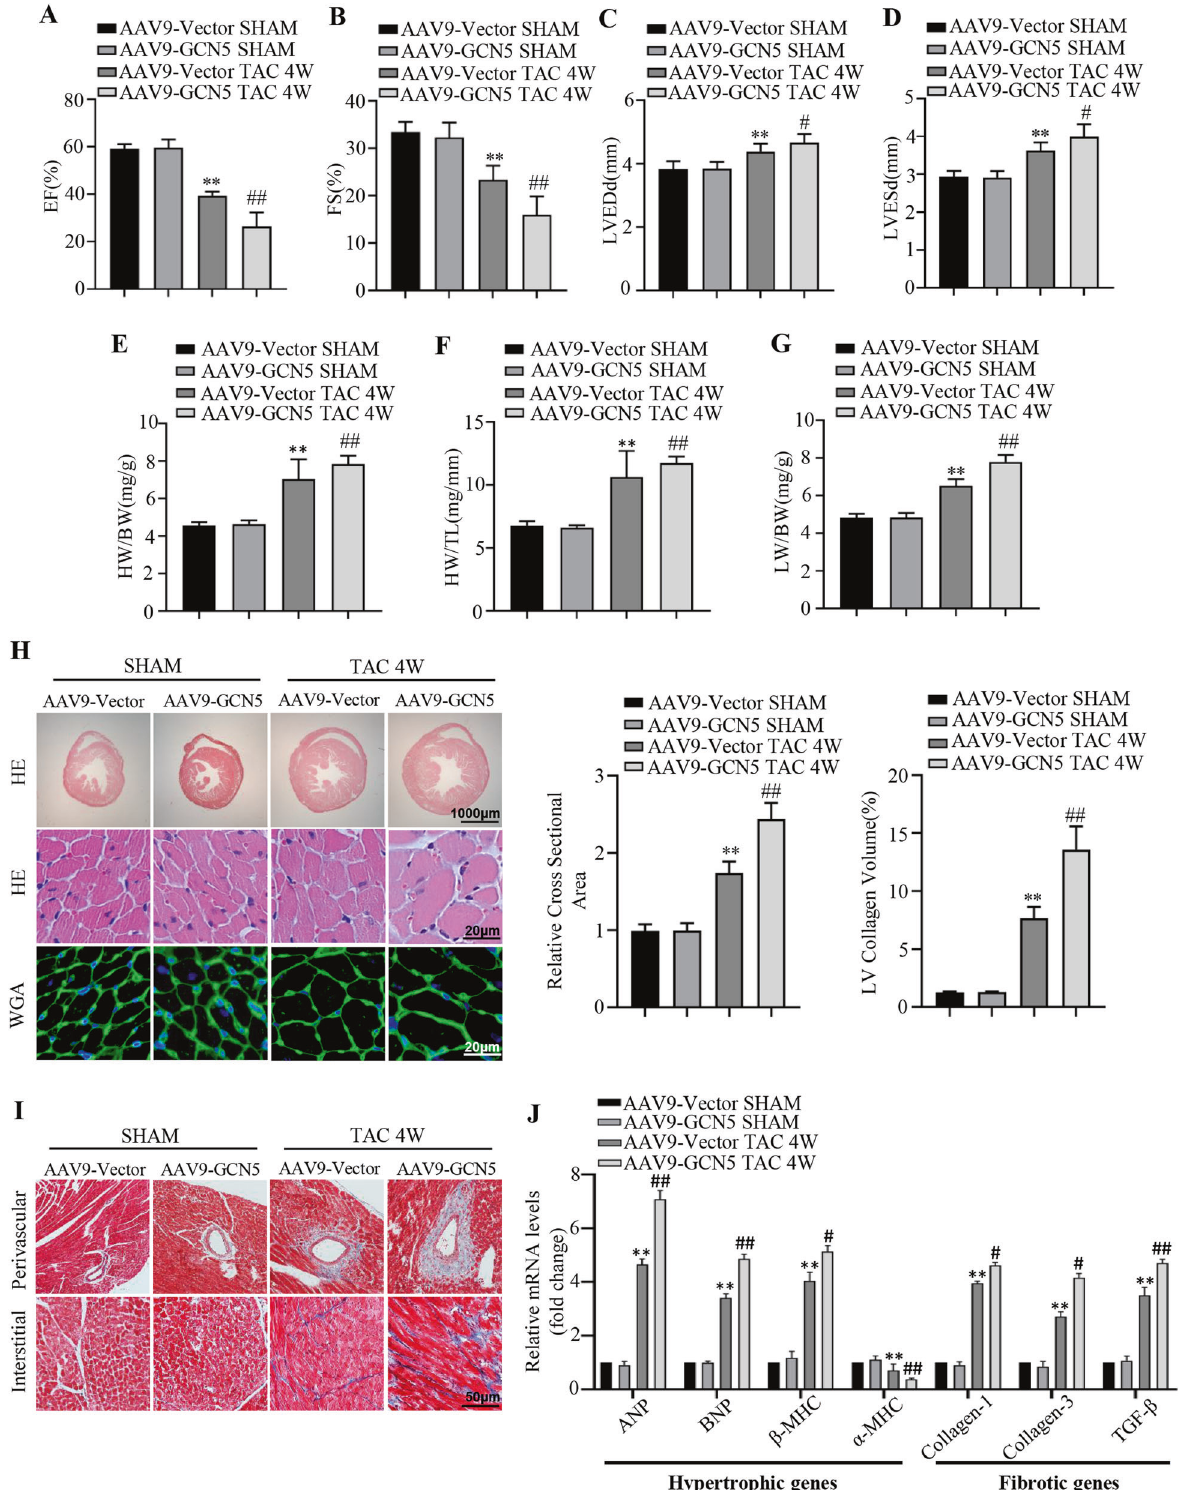
ventricular end-diastolic diameter (LVEDd) and left ventricular end-systolic diameter (LVESd) values. Cardiac remodeling is the main characteristic of cardiac hypertrophy, and enlargement of cardiomyocytes and interstitial fi brosis are acknowledged mani- festations of this process. Histological examination